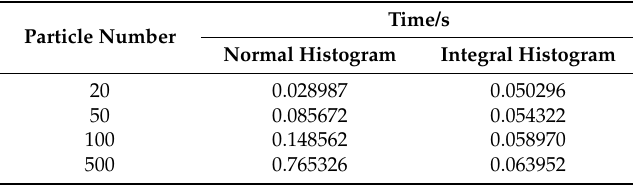
Table 2. The Effects of Different Particle Number on the